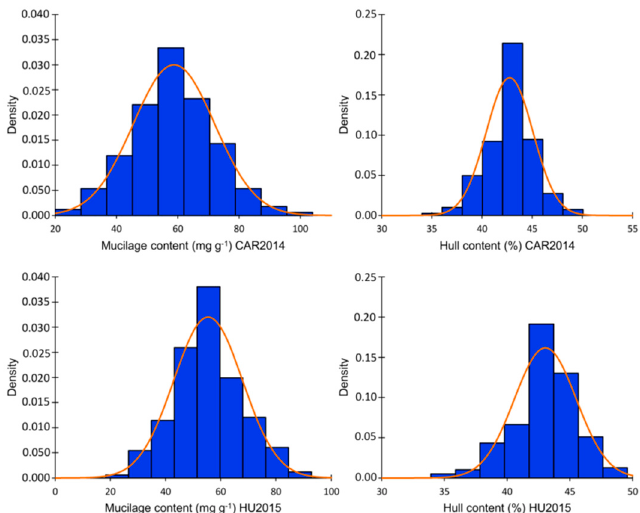
Figure 1. Mucilage (MC) and hull (HC) contents distribution in the association panel in two environments: CAR2014 = Vilcún location 2014, HU2015 = Huichahue location 2015. Values represent the mean of three biological replicates for each trait.